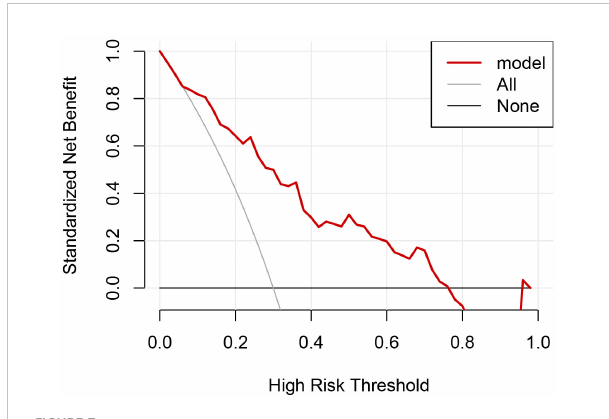
FIGURE 7 DCA of the model for predicting residue of PCTNs after thermal